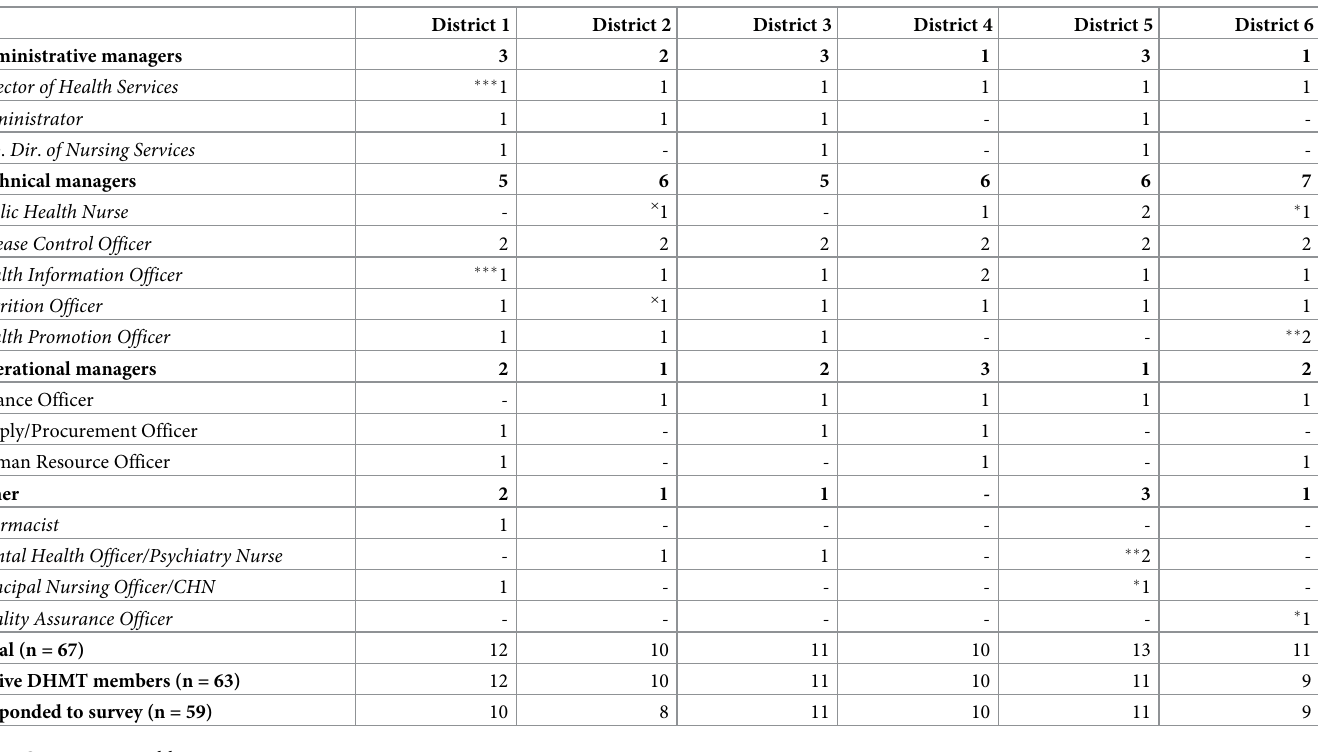
Table 2. Members of the district health management teams across study